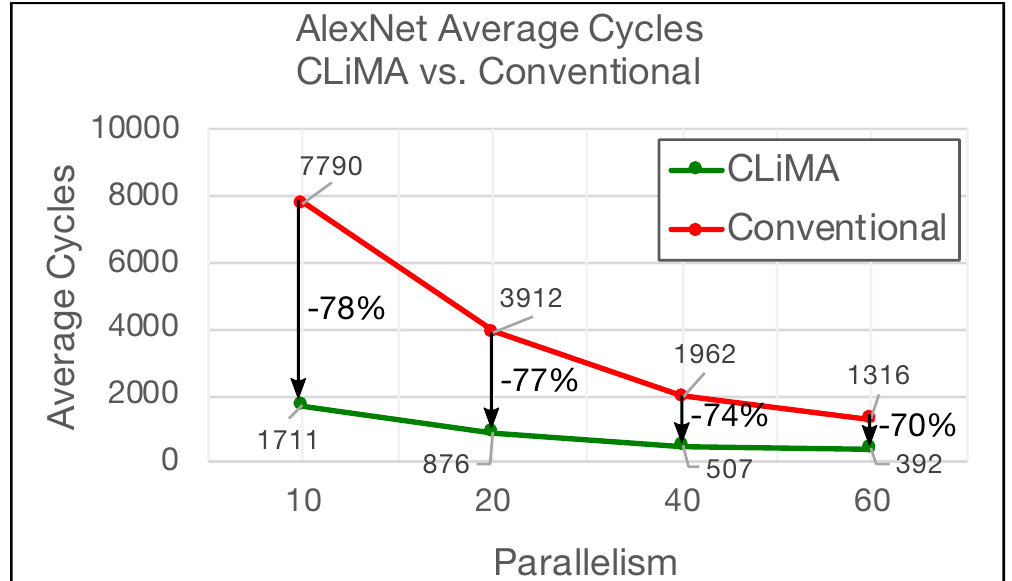
Figure 16. Average cycles needed to execute AlexNet in different scenarios: CLiMA vs. Conventional.